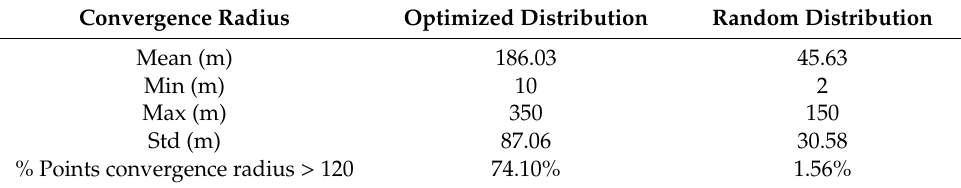
Table 2. Statistical parameters of the optimized and random distribution .